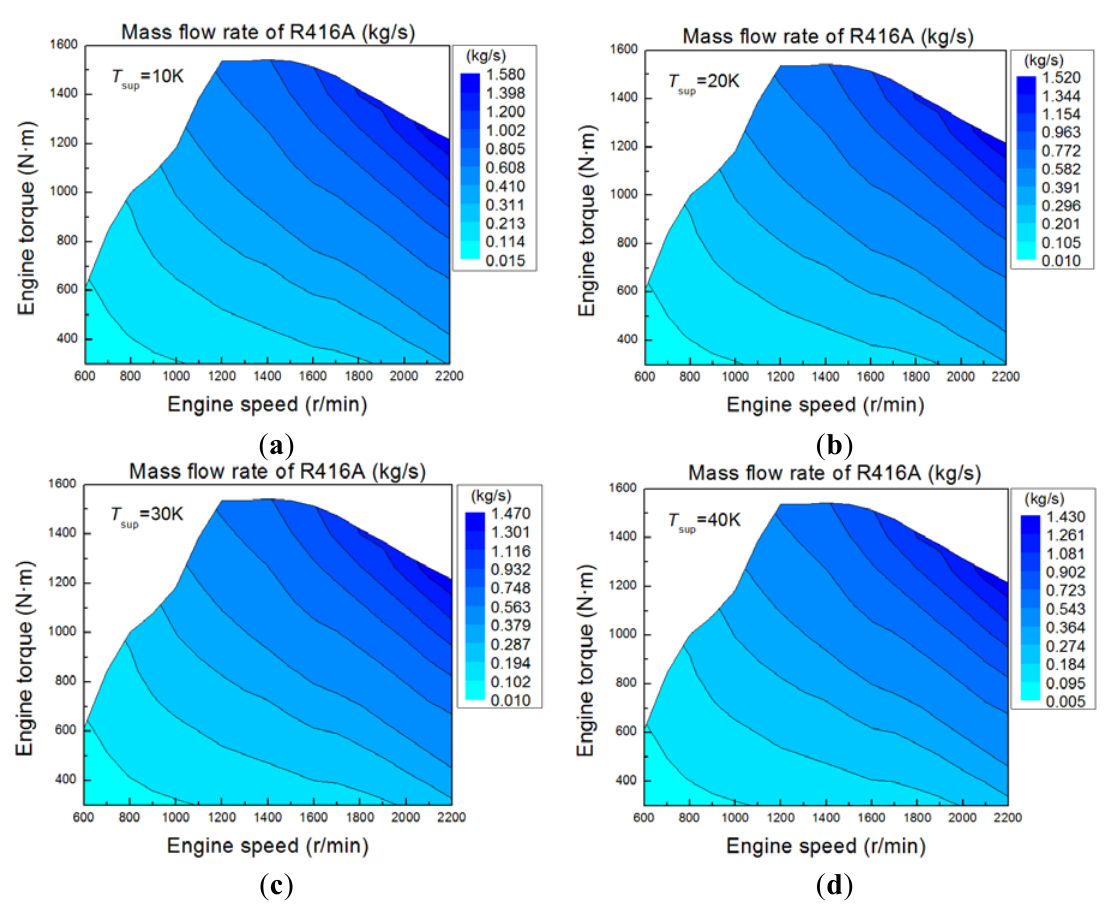
= 10 K; ( b ) T = 20 sup sup